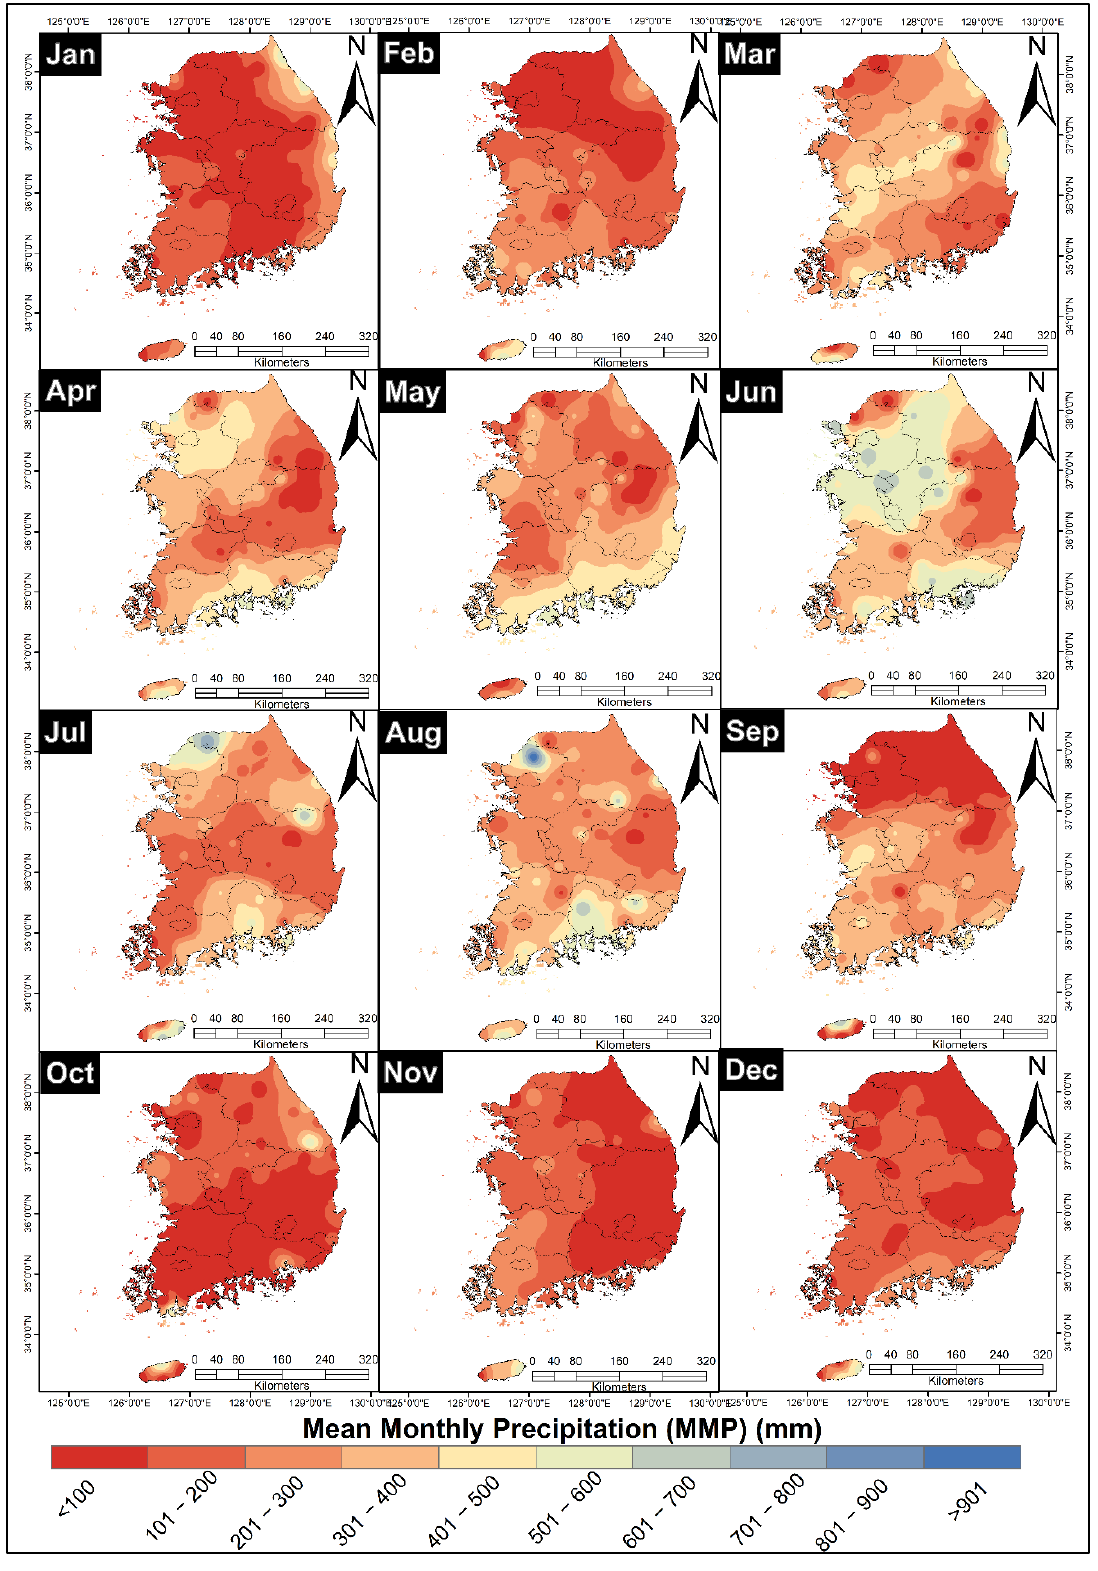
Figure 3. Spatial distribution of mean monthly rainfall in South Korea .